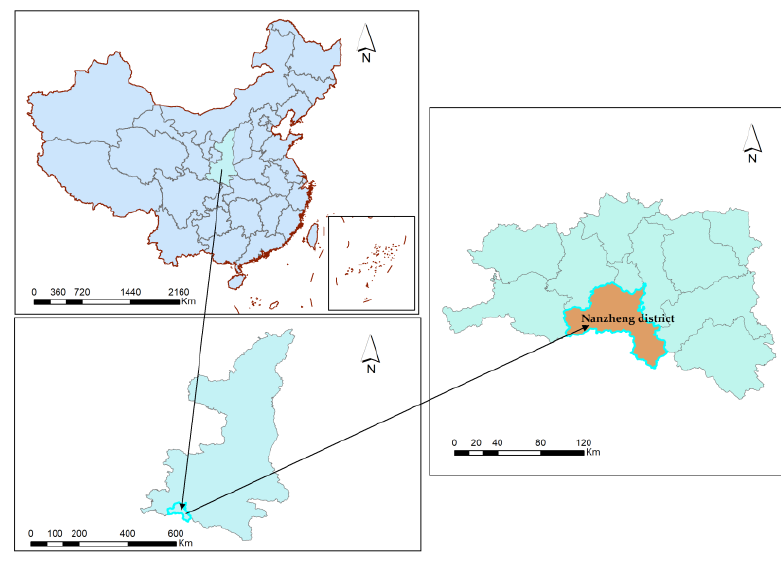
Figure 1. Study area.